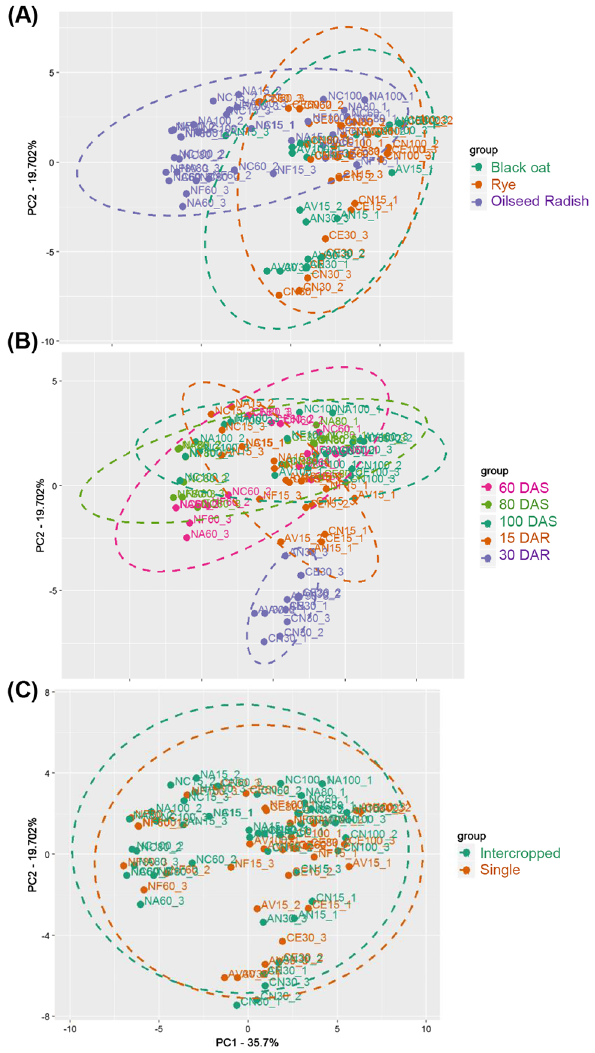
Figure 5: Factorial distribution of principal